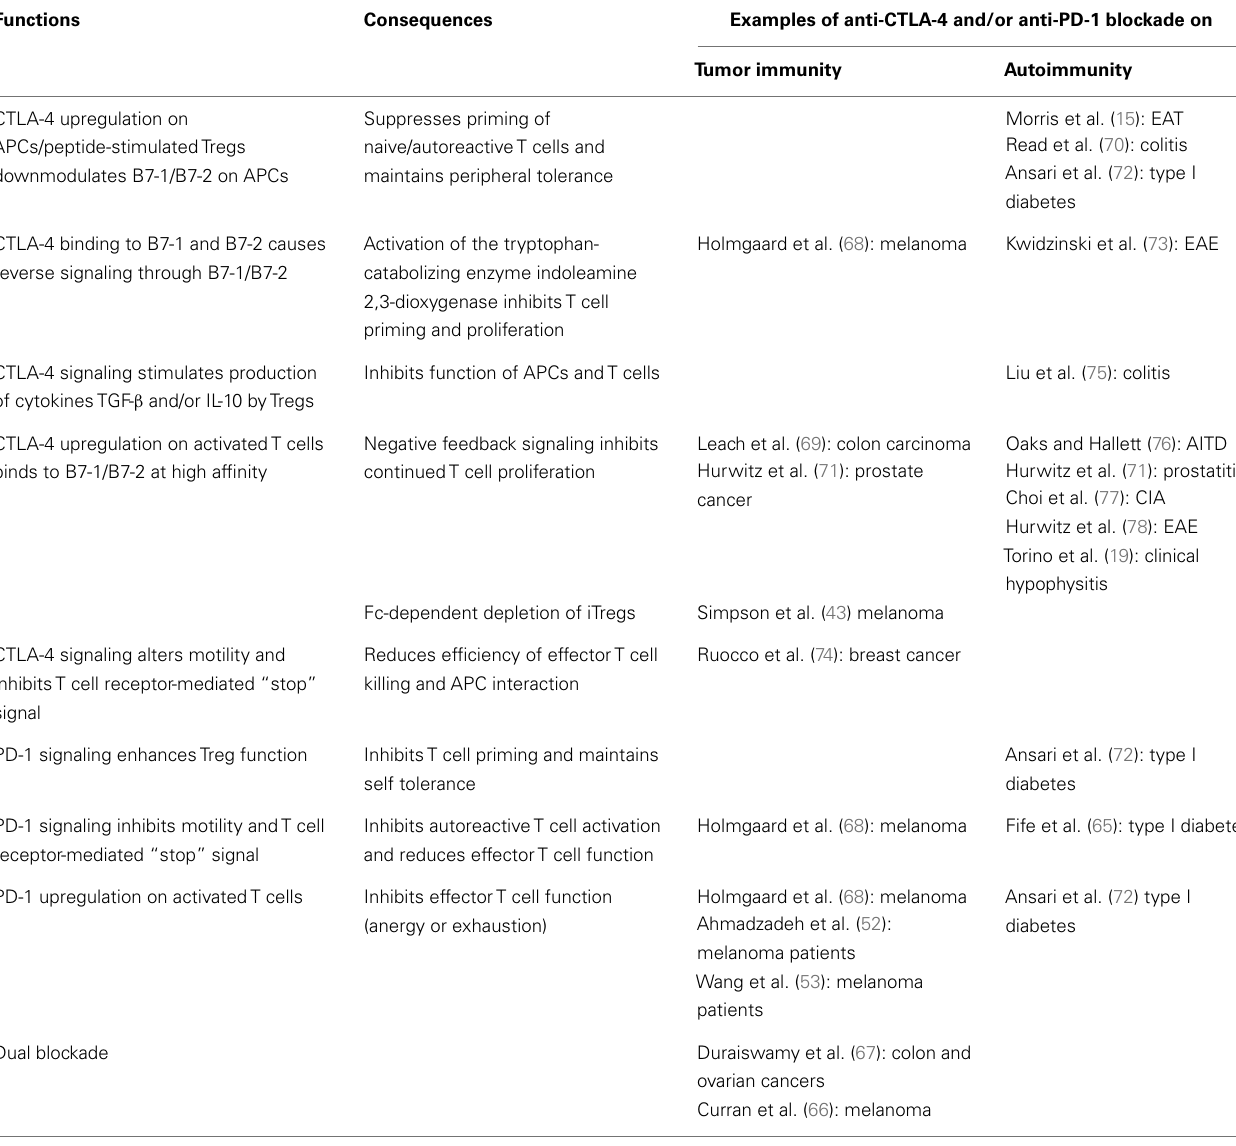
Table 1 | Function of CTLA-4 and PD-1 in the immune network and the impact of immune-checkpoint inhibitors anti-CTLA-4 and/or anti-PD-1 on examples of tumor immunity and autoimmunity